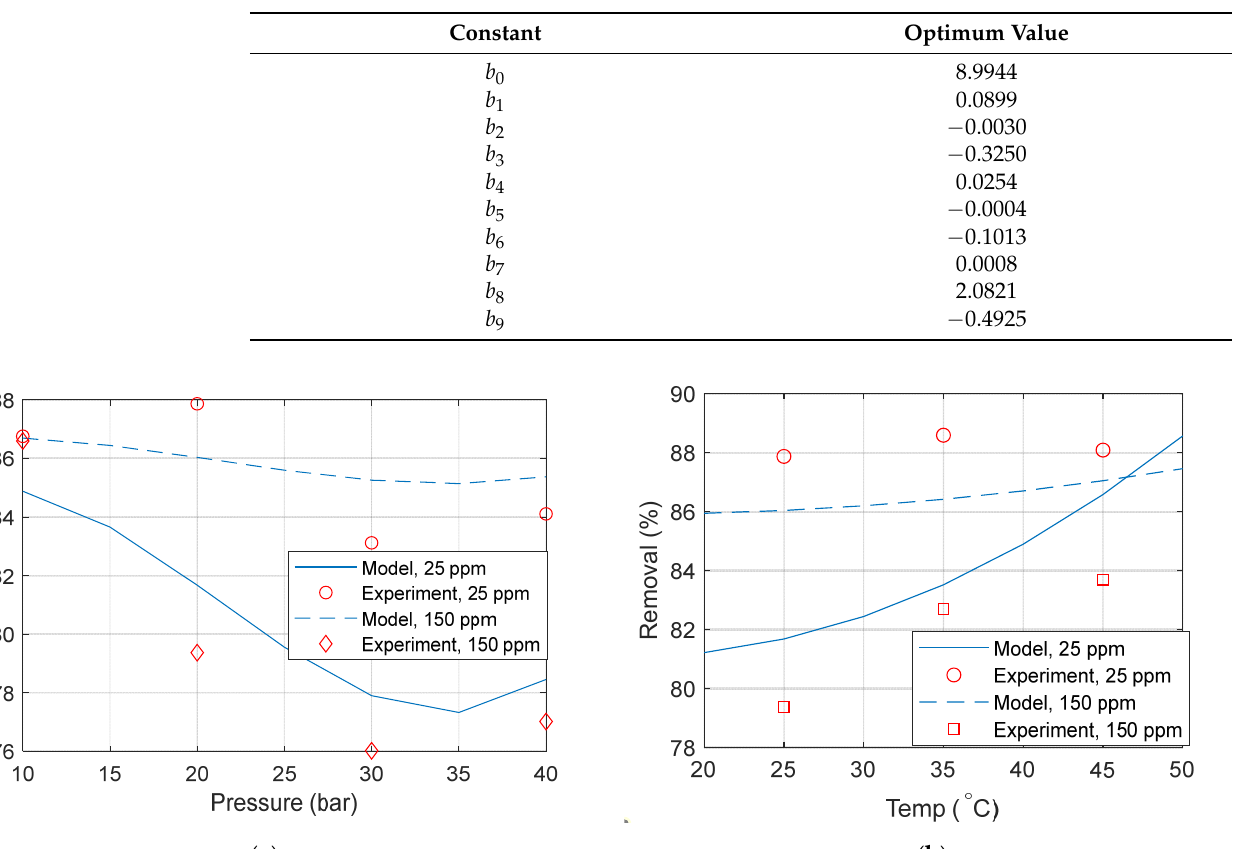
Table 6. Optimum fitting constants copper removal.